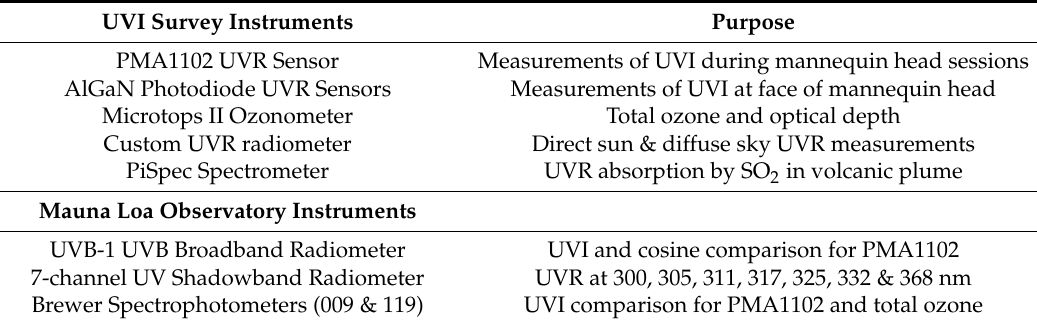
Table 2. Instruments used in the UVI survey and those that served as calibration standards at Mauna Loa Observatory